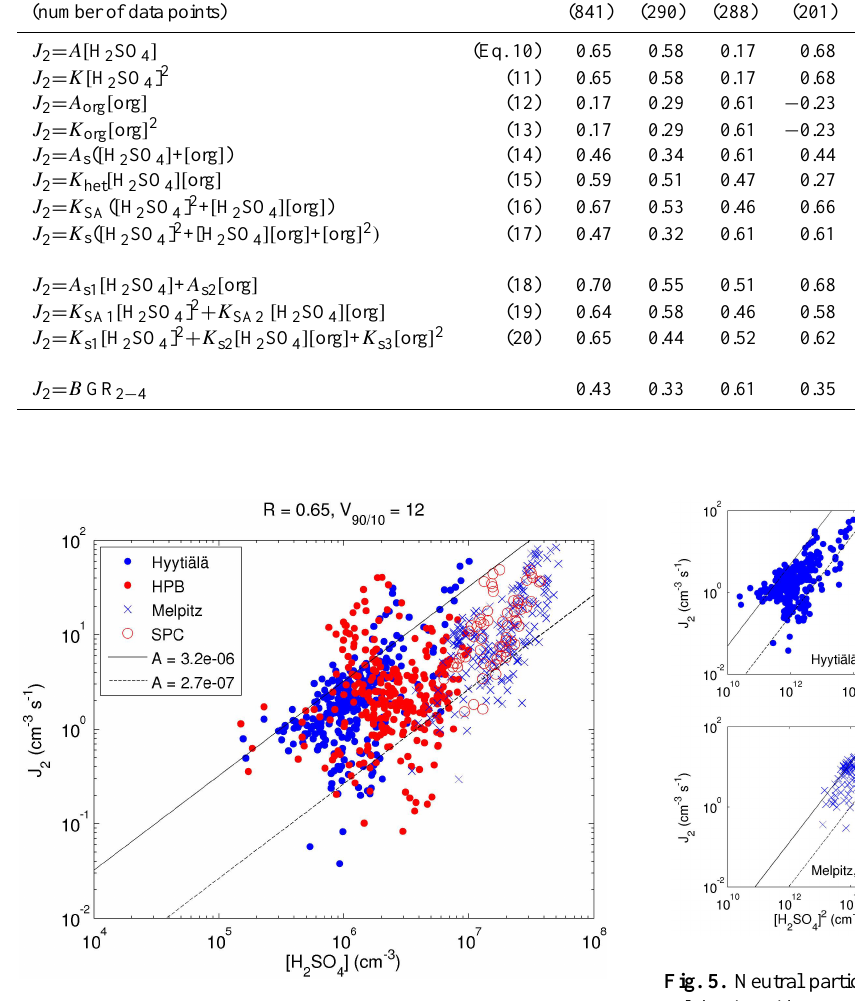
Fig. 4. Neutral particle formation rate J 2 as a function of sulphuric acid concentration. The lines present the 90th and 10th percentile values of the activation coefficient A (Eq. 10), the values of which are given in units (s − 1 ).